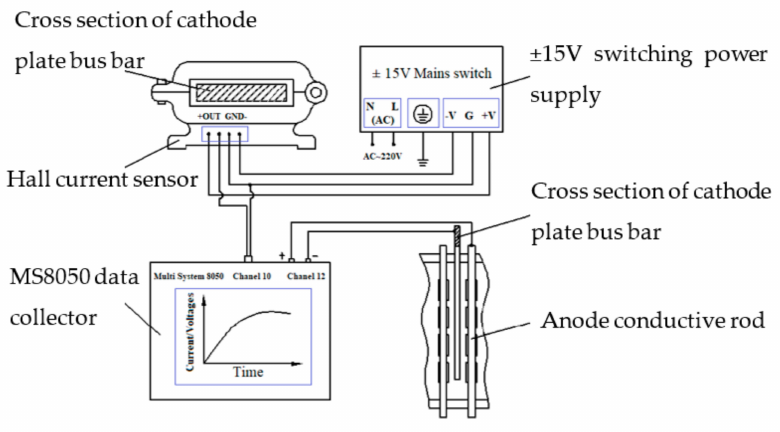
Figure 7. Experimental